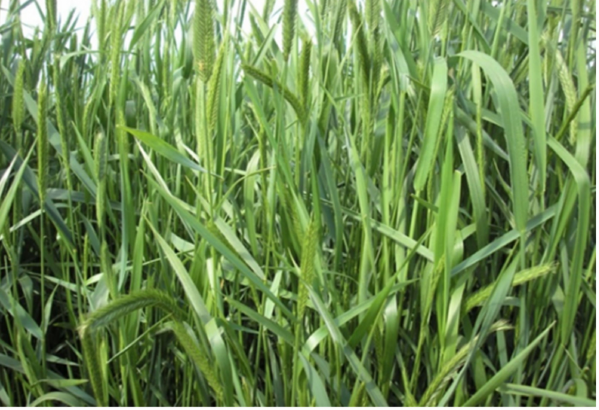
Figure 7. Crested wheatgrass ( Agropyron cristatum L.) Variety Svejina. Author’s photos of Prof. A.